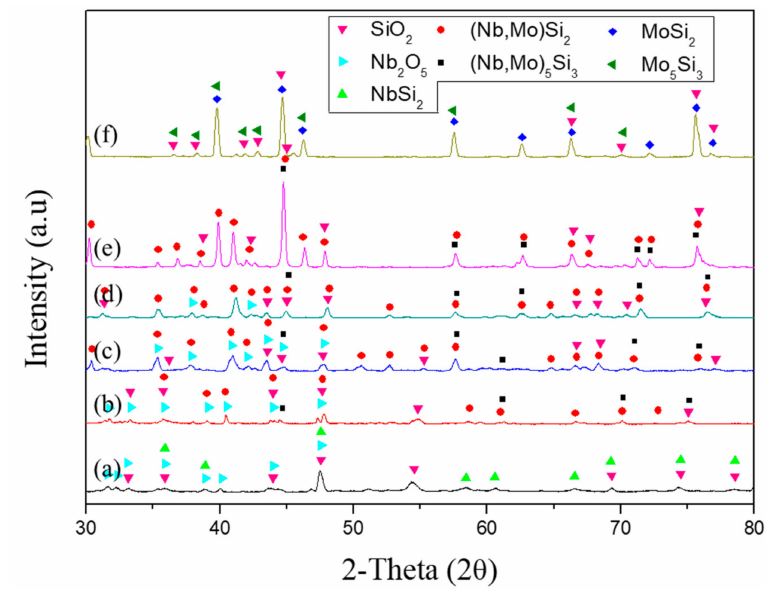
Figure 8. XRD patterns of Si-coated specimens after oxidation tests at 1200 ◦ C for 6 h with substrate compositions of ( a ) Alloy 1 (Nb), ( b ) Alloy 2 (Nb 73.6 Mo 26.4 ), ( c ) Alloy 3 (Nb 51.2 Mo 48.8 ), ( d ) Alloy 4 (Nb 35.1 Mo 64.9 ), ( e ) Alloy 5 (Nb 25.7 Mo 74.3 ), and ( f ) Alloy 6